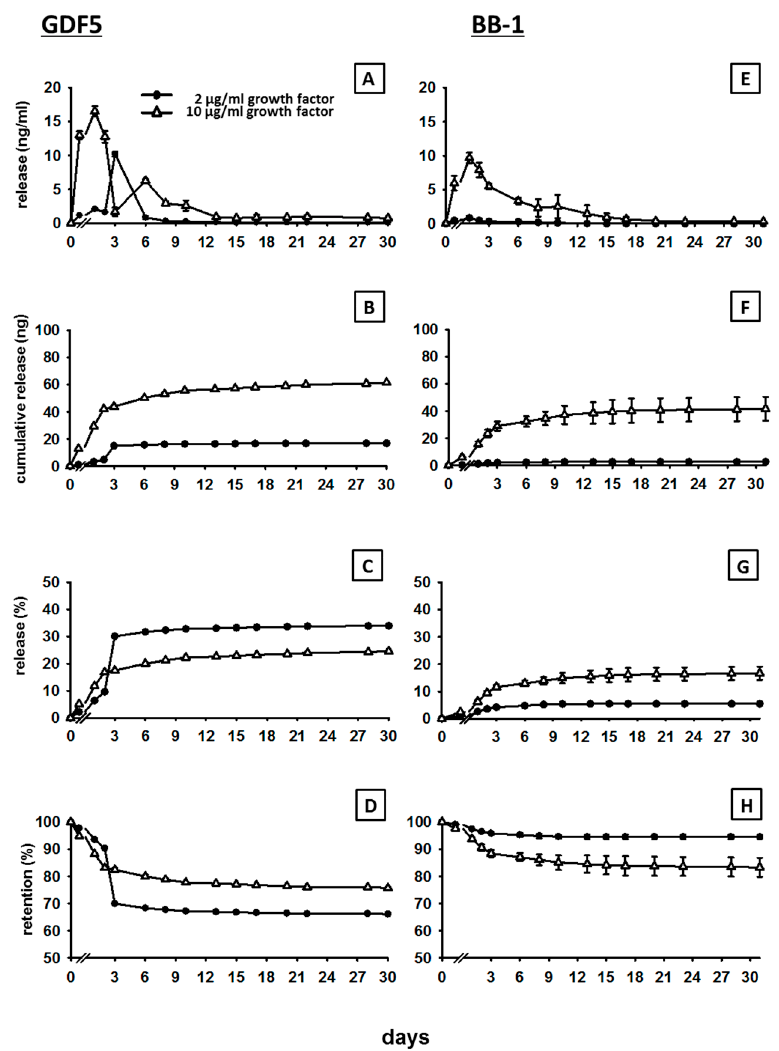
Figure 1. In vitro release of 2 and 10 µg/mL GDF5 and BB-1 from CPC. Cement discs ( r = 2.0 mm, h = 2.0 mm, V = 25.12 µL) were loaded with 2 or 10 µg/mL GDF5 and BB-1, ground, and incubated at 37 °C in 1 mL of cell culture medium + 10% FCS for 1 h, as well as 1, 2, 3, 6, 8, 10, 13, 15, 17, 20, 22, 28, and 31 days. The release of GDF5 ( A ) and BB-1 ( E ) from ground cement discs was measured by ELISA and used for the calculation of cumulative release ( B , F ), % release ( C , G ), and retention ( D , H ; n =